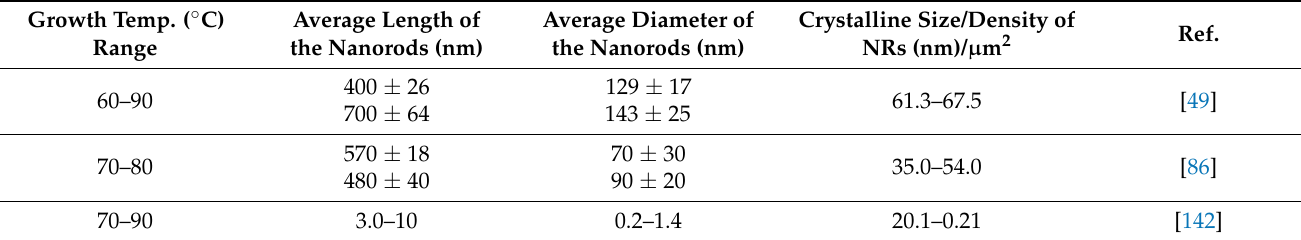
Table 3. Variation of the length, diameter, and structural parameters of the grown ZnO nanorods at different temperatures. Adapted from ref.